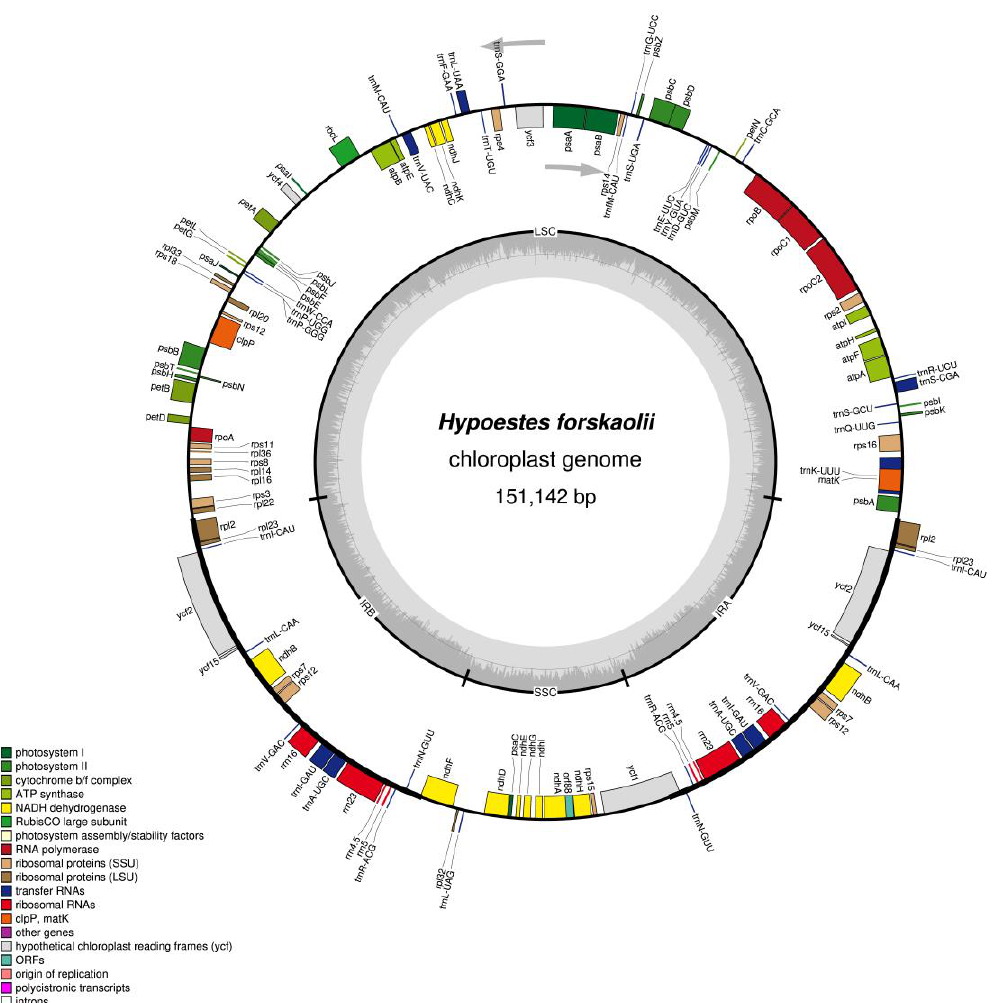
Figure 1. The structure of the H. forskaolii cp genome. Genes inside the circles are transcribed clockwise, while those outside the circles are transcribed counterclockwise. The colorful bar displays genes that are known to be functioning. The inner circle’s dark grey and light grey colors, respectively, designate the GC and AT